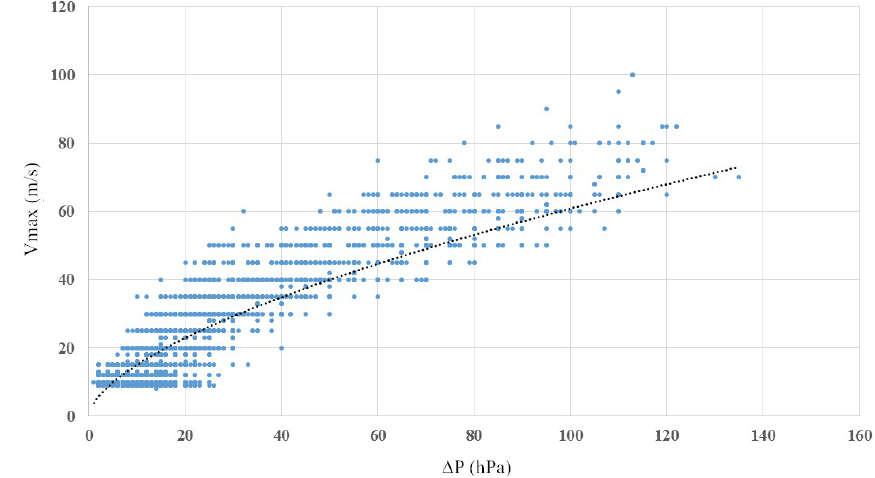
Figure 8. The relation between the pressure difference ( (cid:49)P ) and the maximum wind velocity ( V max ).